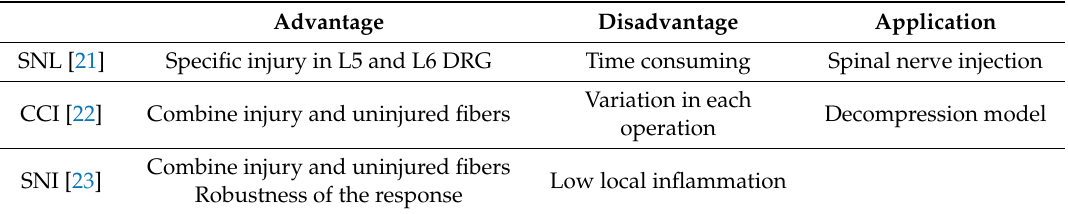
Table 1. Injury-induced neuropathic pain